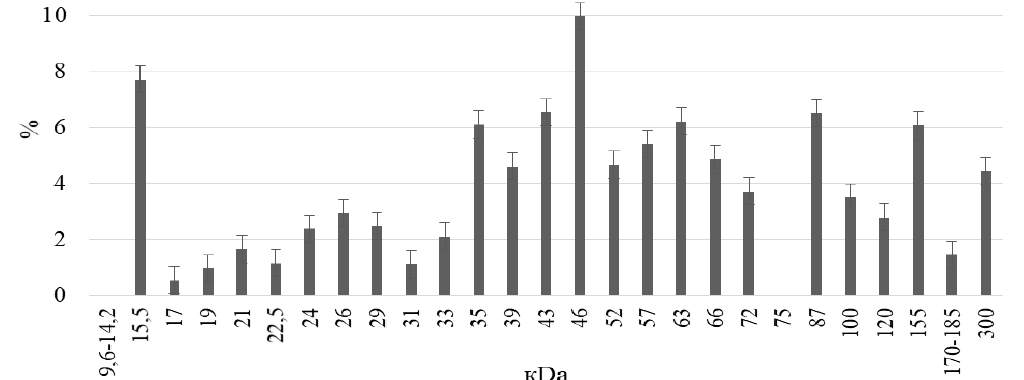
Fig. 5. Structural proteins of the basolateral membrane of the jejunum enterocytes of eighth-month-old cattle fetus (M ± m; %; n =